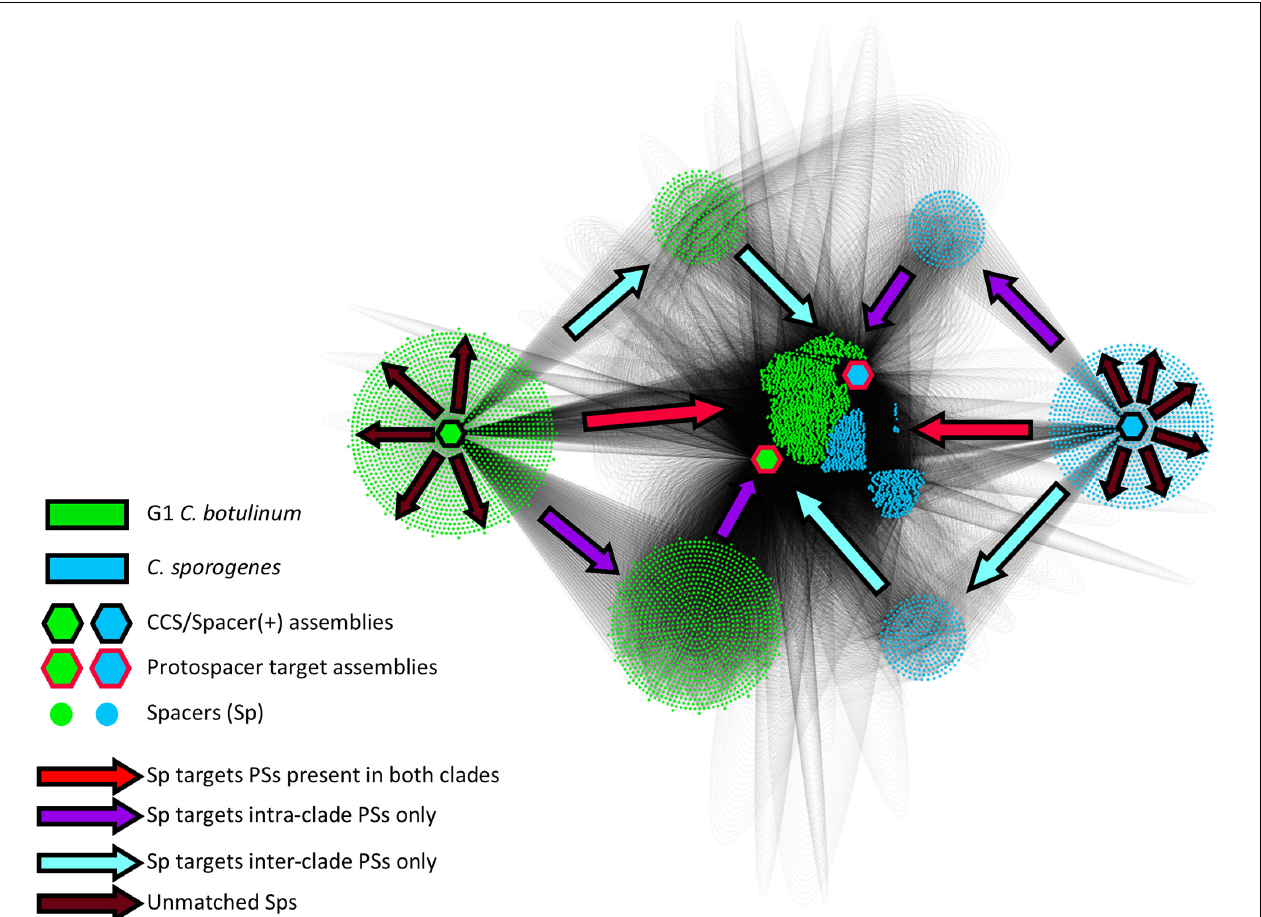
FIGURE 7 | Most targeted protospacers are present in both G1 C. botulinum and C. sporogenes . Figure shows a directed matrix made in Cytoscape (Shannon, 2003) connecting CRISPR-Cas(+) assemblies (black outlined hexagonal node) to protospacers(+) (red outlined hexagonal node) through a shared intermediate node representing a unique spacer (circular node). For all spacer–protospacer interactions, each strain was collapsed into one of four clade-specific groups (G1 C. botulinum / C. sporogenes + spacer/protospacer). Both species are represented as hexagonal nodes connected to each spacer ID by edges that are 1:1 between spacer and species-spacer, and 1:X matched protospacers between spacers and protospacer-species. The arrow legend indicates spacer targets. Red arrows indicate directionality of spacers that target protospacers present in both species and represent 78% of all spacer–protospacer pairs ( Table 4 ).